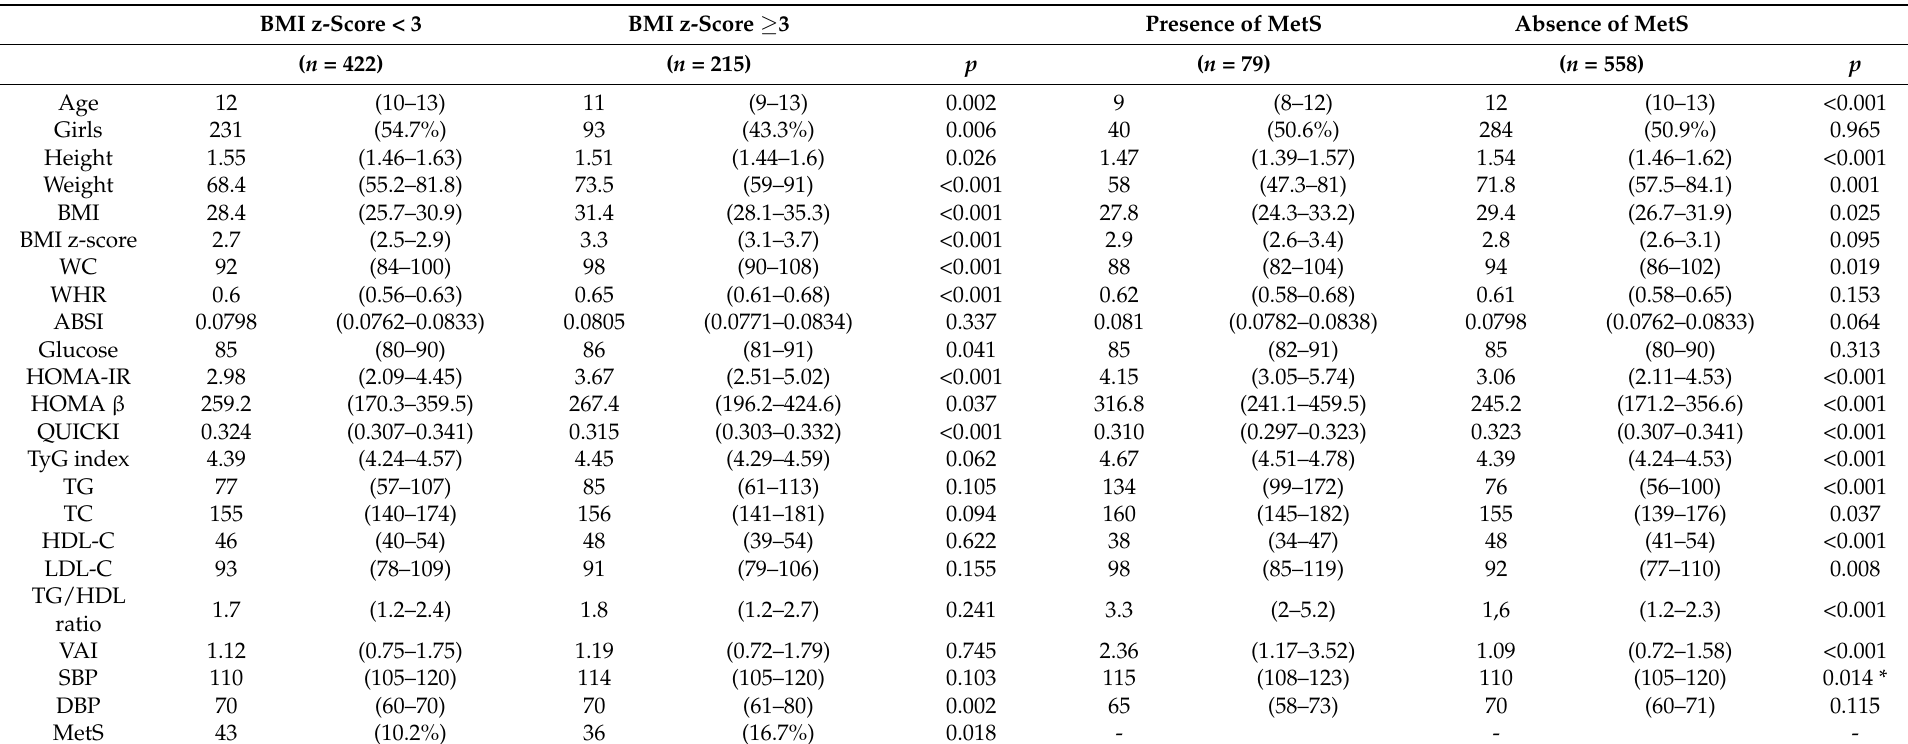
Table 2. Characteristics of the population according to BMI z-score and the presence/absence of